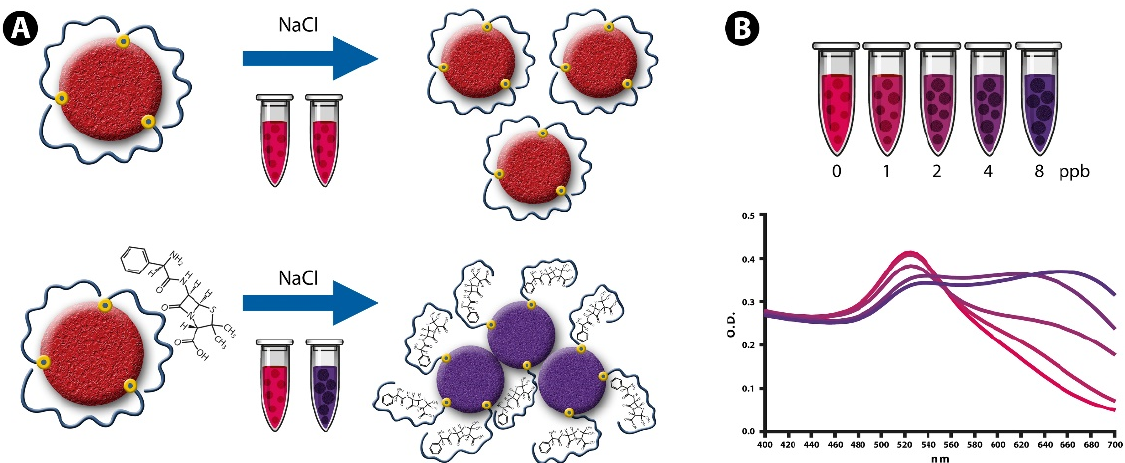
Figure 1. Schematic illustration showing the sensing principle of aptamer-conjugated AuNPs for the colorimetric detection of antibiotic residues present in raw milk. ( A ) Covalently conjugated aptamers in a random coiled linear structure inhibit salt-induced aggregation, while the conformational change induced by antibiotic interaction decreases surface protection and allows the aggregation of AuNPs upon the addition of NaCl. ( B ) Absorption spectra of AuNPs showing antibiotic-induced aggregation of the nanoparticles and the resulting shift in the plasmon resonance peak (from red to blue–purple).